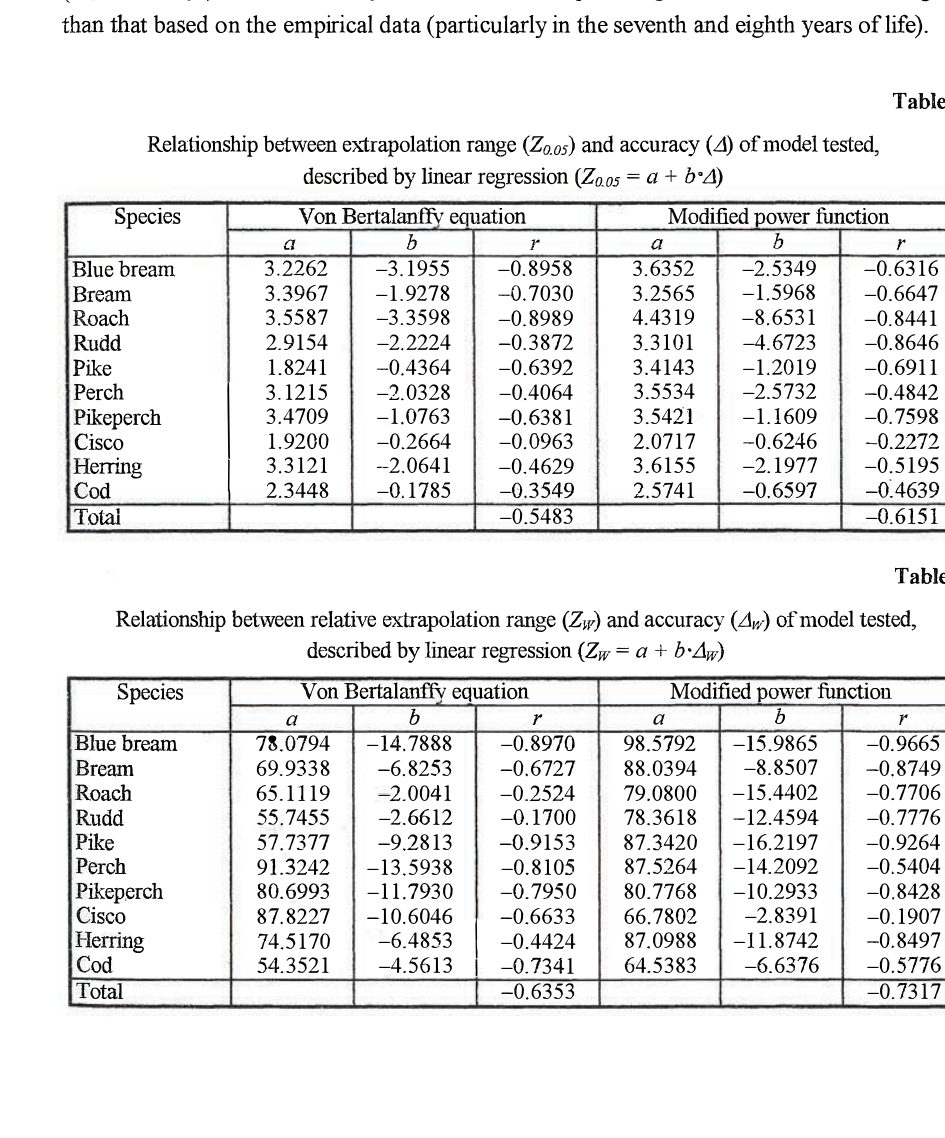
Fig. 1, in which the real and extrapolated length growth rates of the Szczecin Lagoon perch are presented (based on data reported by Szypula 1994b ), shows that the extrapolated growth curve almost ideally fits the empirical data; the empirical and calculated lengths for the final year of life are identical, which suggests that the true extrapolation range is likely to be by a few years wider than that calculated with the model used. At the same time, the av­ erage difference between the empirical and model data was in this case minimal for the first 4 years of life (A= 0.02 cm; Llw = 0.14%). Fig. 2 shows a reverse pattern, found for the Szczecin Lagoon pikeperch (data reported by Nagi�c 1961). The average differences in this case were large (Li = 2.49 cm; Llw = 4. 71 % ), the extrapolation range being relatively narrow (Z0_ 05 = 0.97 yr). As of the fifth year oflife, the extrapolated growth curve runs much higher than that based on the empirical data (particularly in the seventh and eighth years oflife ).